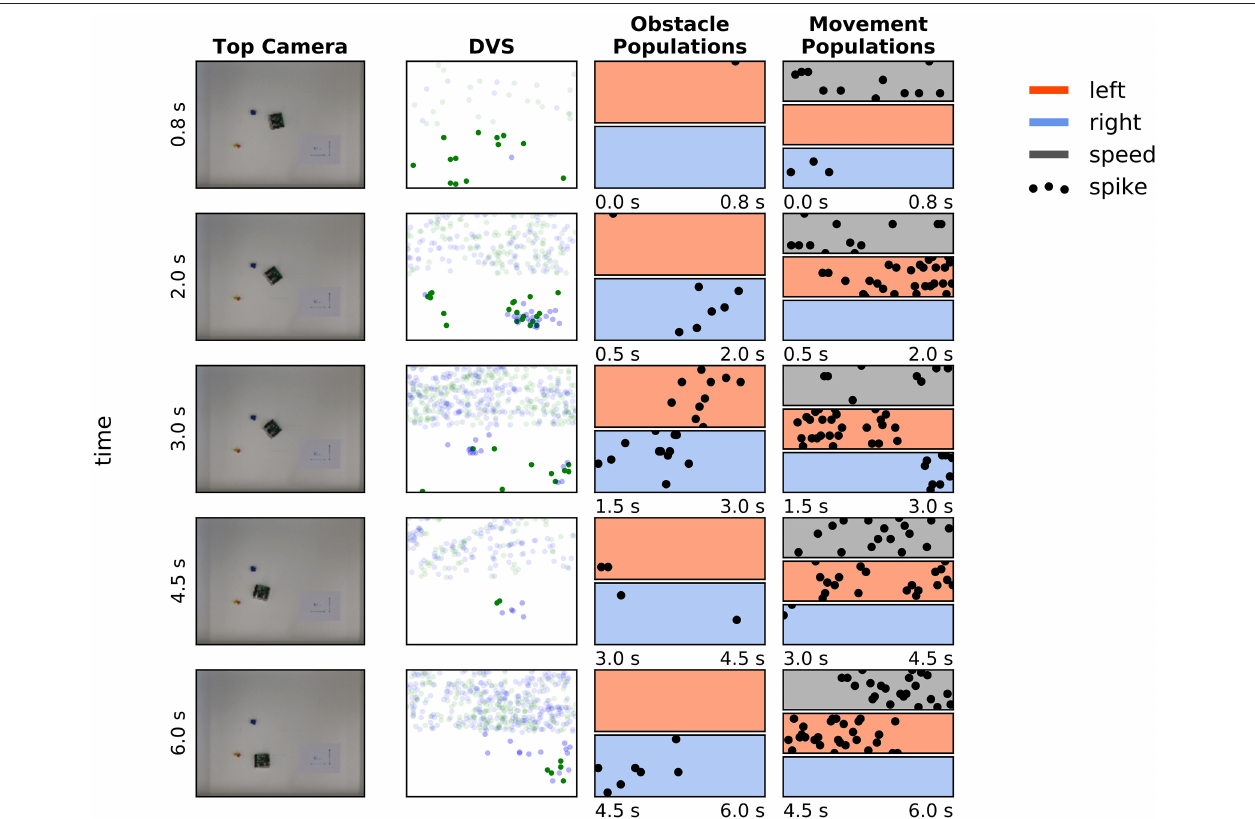
FIGURE 8 | Avoiding a pair of obstacles. First column: Snapshots of four moments in time during avoidance of a cup, moved into the robot’s trajectory. Second column: DVS “frames”—events, accumulated over a 0.5 s time window. Green dots are off events, blue dots are on events. Events in the upper part of the frame were not considered for the obstacle avoidance. Third column: Activity of the obstacle representing populations in 0.6–1.5s before the camera snapshot in the first column was taken (red—left population ( n OL ), blue – right population ( n O R ); each population has 16 neurons). Forth column: Activity of the drive left (red), drive right (blue), and speed population on the ROLLS chip in the same time as on the plots in column 3.